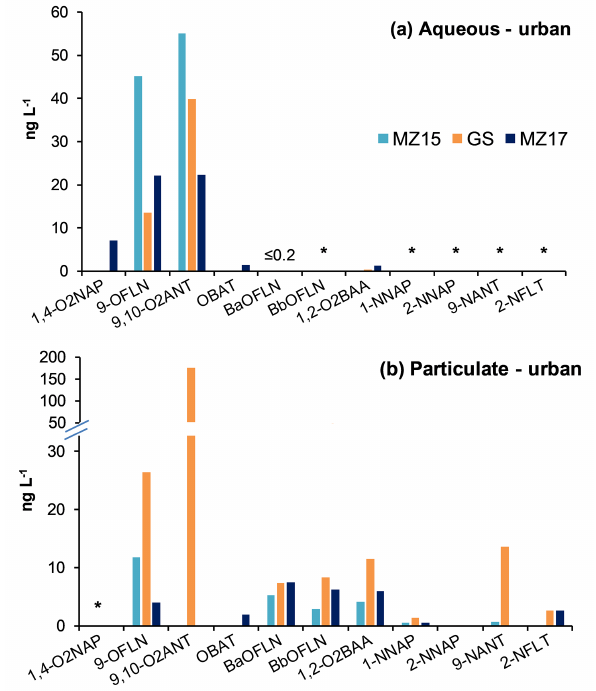
Figure 2. N/OPAHs in rural and remote snow samples; ∗ indicates values <LOQ in all